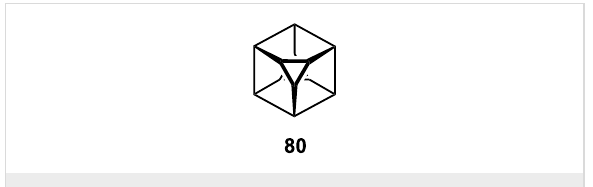
Figure 8: D 3 d symmetric C 8 H 8 , a bis-truncated cubane.